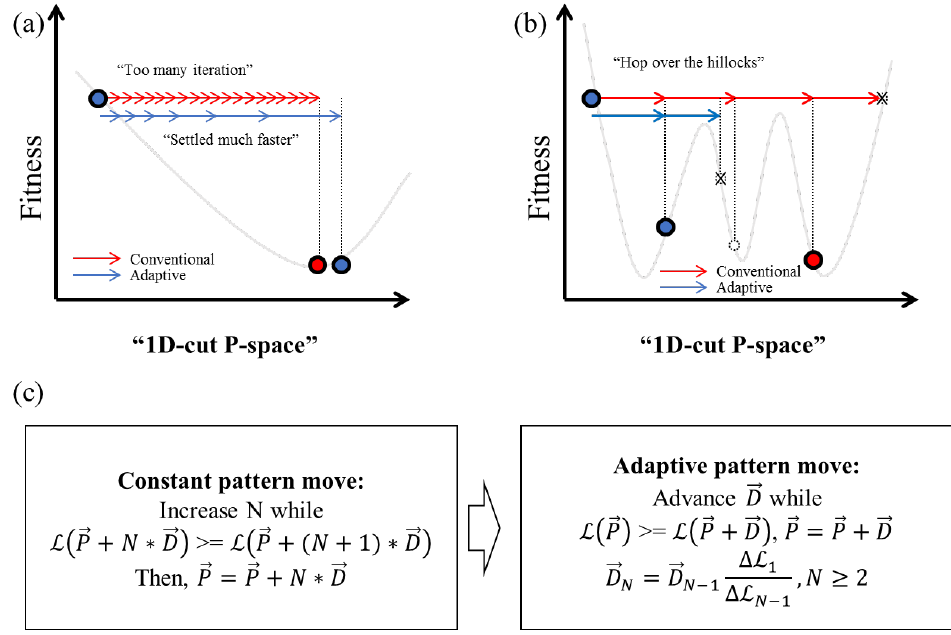
Figure 3. ( a ) The graphical interpretation of pattern move when the pattern vector is relatively small and fitness valley has a gradual slope. Red arrow represents the pattern vector of the conventional method and blue arrow represents the adaptive pattern vector. Unnecessary iteration of evaluations and advances is needed with this circumstance with the constant vector. Scaling the pattern vector adaptively, pattern move can be settled much faster; ( b ) the graphical interpretation of pattern move when the pattern vector is relatively large and fitness valley has a steep slope. In this circumstance, the algorithm could not capture the underlying structure of fitness valley and leads to wrong conclusion. Along with the adaptive pattern vector, this misleading vector can be reduced; ( c ) the mathematical description of adaptive pattern move. Constant pattern of conventional method is revised to vary adaptively utilizing the relative difference of fitness to scale the pattern